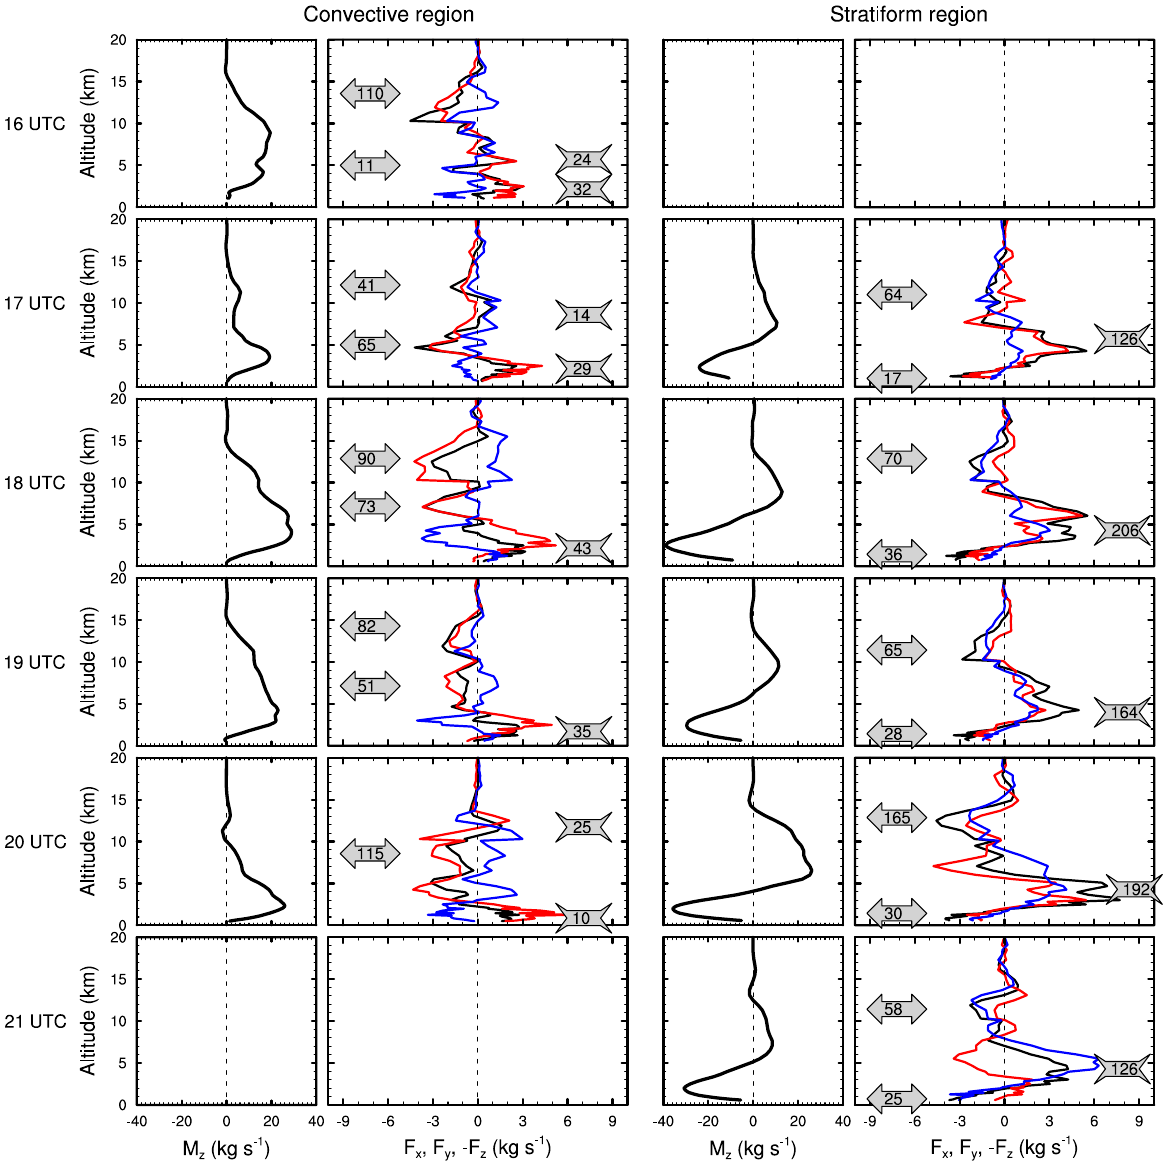
Fig. 11. Result of mass transport budget of the MCS in the convective (two columns left) and stratiform (two colums right) regions every hour from 15 August 2004 at 16:00UTC to 21:00UTC (1st and 3rd column). Vertical profile of air mass flux M z in 10 9 kgs − 1 (2nd and 4th column). Vertical profiles of line-transverse F x (red), line-parallel F y (blue) and vertical − F z (black) mass fluxes convergences in 10 9 kgs − 1 . The grey arrows represent the entrainment/detrainment air mass fluxes (in 10 9 kgs − 1 ).